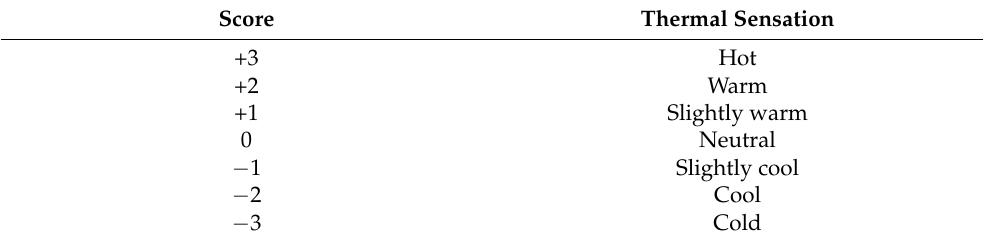
Table 1. Thermal sensation scale.